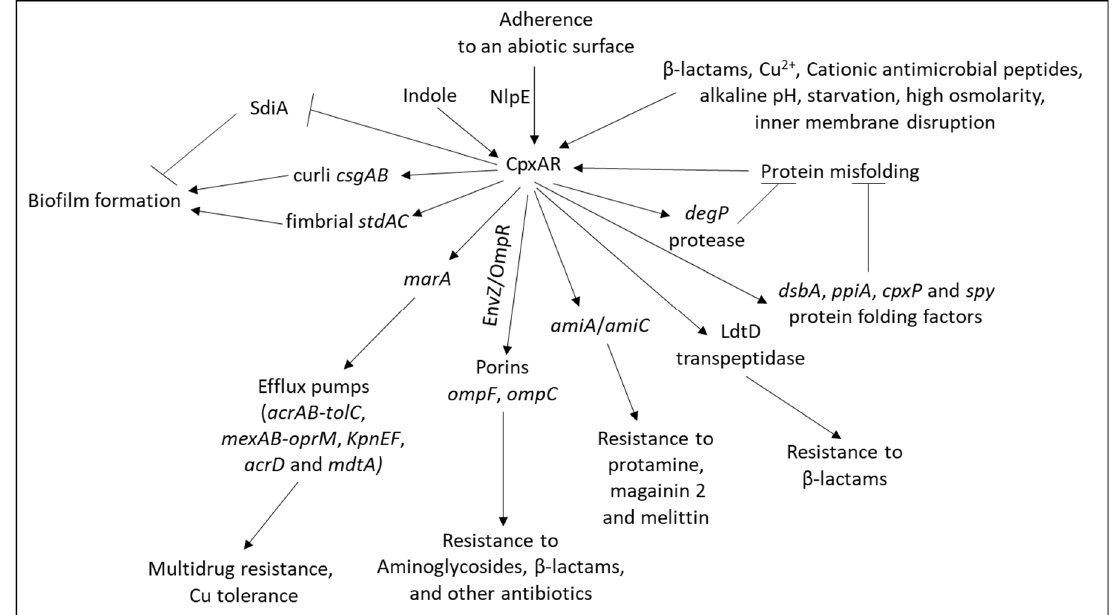
Figure 10. The Cpx envelope stress-response system. The CpxAR TCS is activated by various stress stimuli including protein misfolding, certain antibiotics, inner membrane disruption, alkaline pH, starvation, high osmolarity, and adherence to an abiotic surface. The activation of CpxAR leads to large alterations in gene expression in an attempt to protect the bacteria from the environmental stressor. Among others, it induces the expression of genes assisting in removing misfolded proteins and genes involved in biofilm formation. Additionally, CpxAR increases the expression of various genes (e.g., efflux pumps, porins, amidases, and the ldtD transpeptidase) that confer multidrug resistance and copper tolerance.